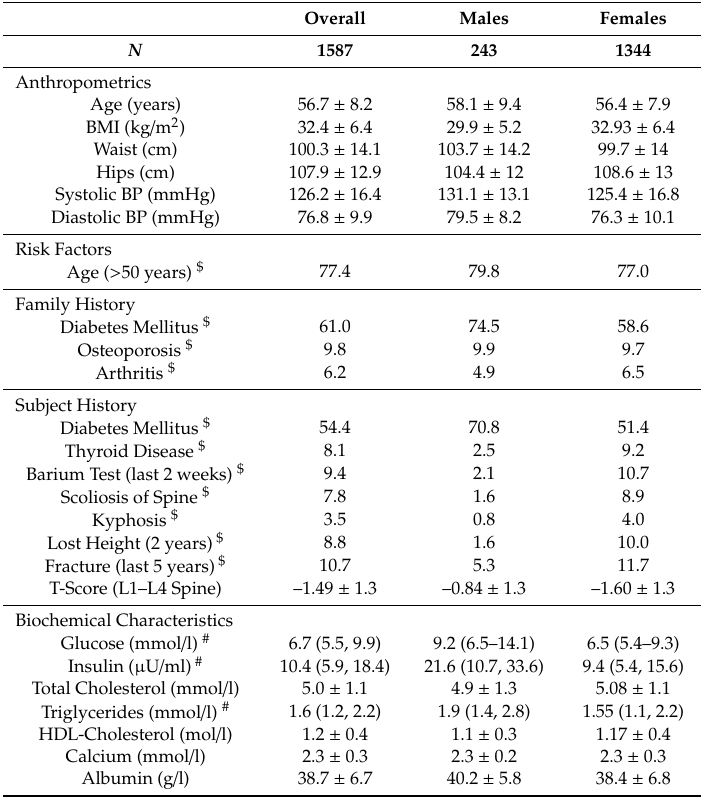
Table 1. General and biochemical characteristics of participants.